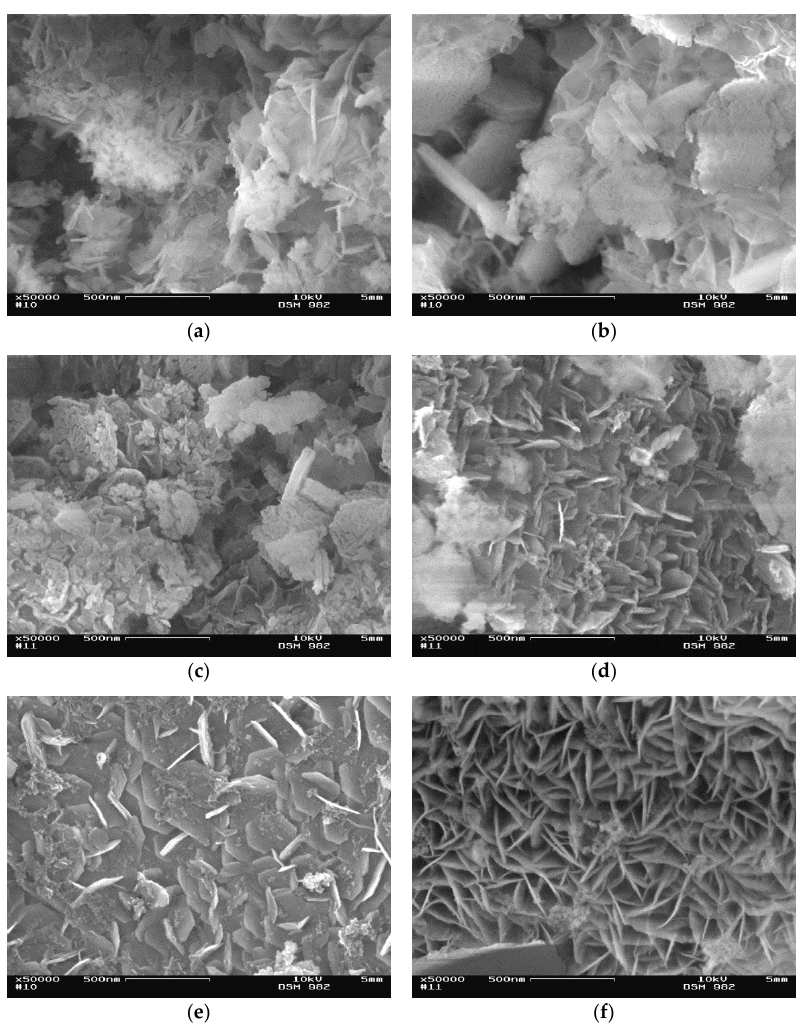
Figure 11. SEM images of M3/SiO 2 mixed oxides with ( a ) 0 h, ( b ) 5 h, ( c ) 9 h, ( d ) 12 h, ( e ) 24 h, ( f ) 48 h duration of autoclave treatment of the MgCO 3 precipitated suspension, at 50,000× magnification.